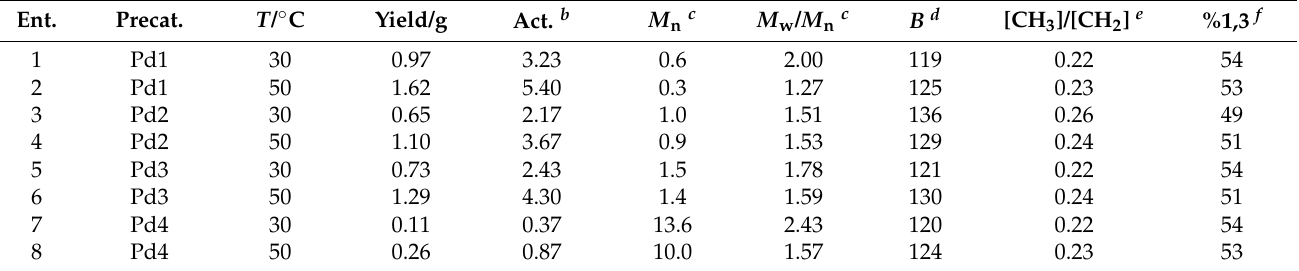
Table 1. Effect of Catalysts and Temperatures on Propylene Polymerization. a .